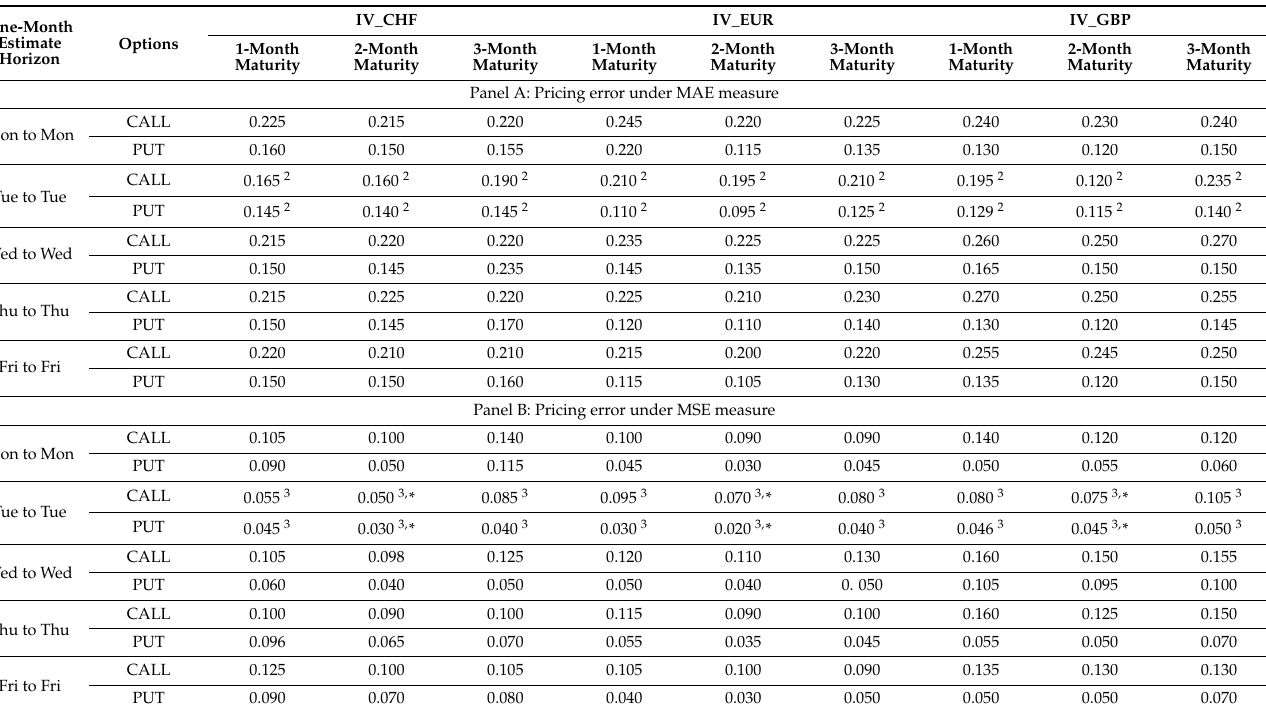
Table 6. Estimate options pricing error for the one-month horizon.